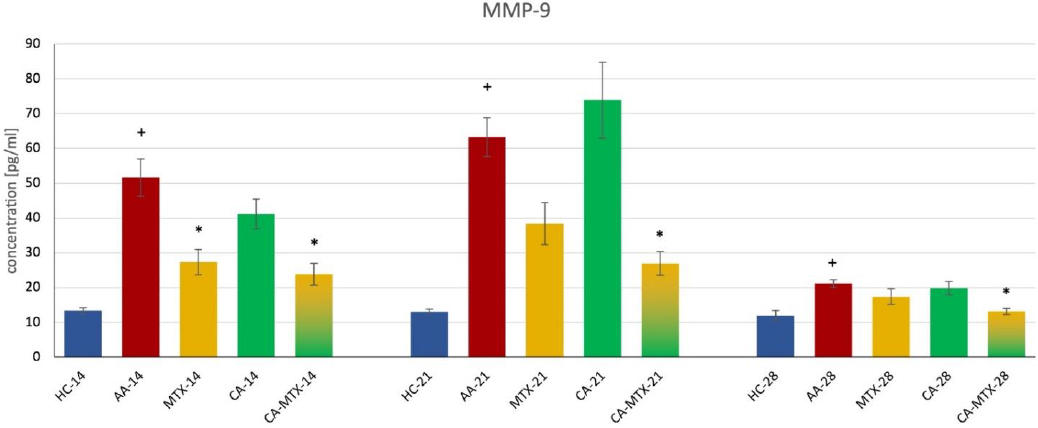
Figure 4. Levels of matrix metalloproteinase 9 (MMP-9) in plasma on the 14th, 21st, and 28th day. + HC vs. AA, * AA vs. MTX/CA/CA-MTX, p ≤ 0.05.